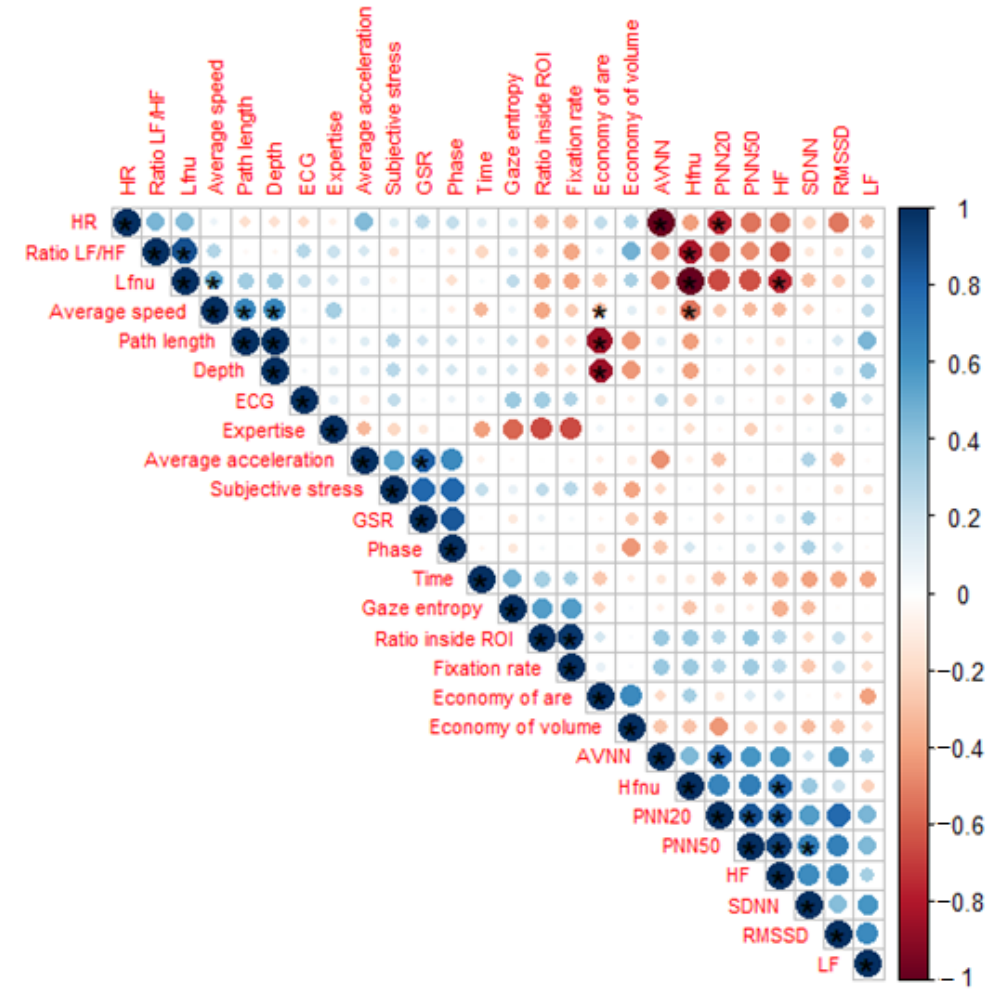
Figure 6. Correlation matrix. Color map and size represent the correlation between the variables. A star is depicted whenever the correlation was statistically significant according to Pearson or Spearman’s test.